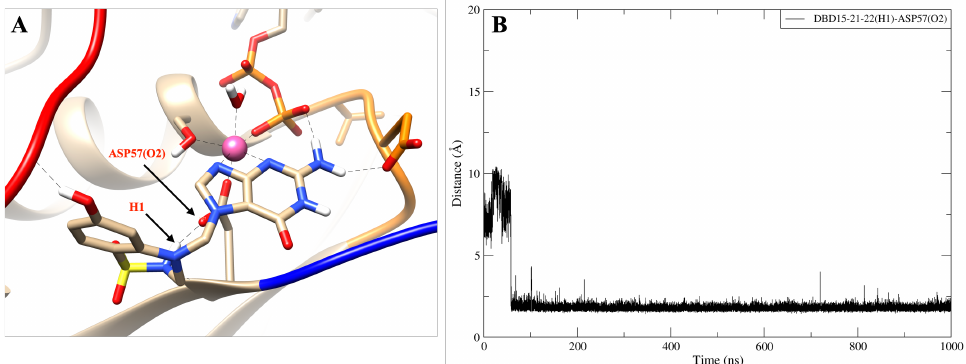
Figure A15. The hydrogen bond interaction between DBD15-21-22 (H1) and ASP57 (O2). ( A ) Rep- resentative snapshot of HB DBD 15 − 21 − 22 ( H 1 ) − ASP 57 ( O 2 ) ; ( B ) distance between DBD15-21-22 (H1) and ASP57